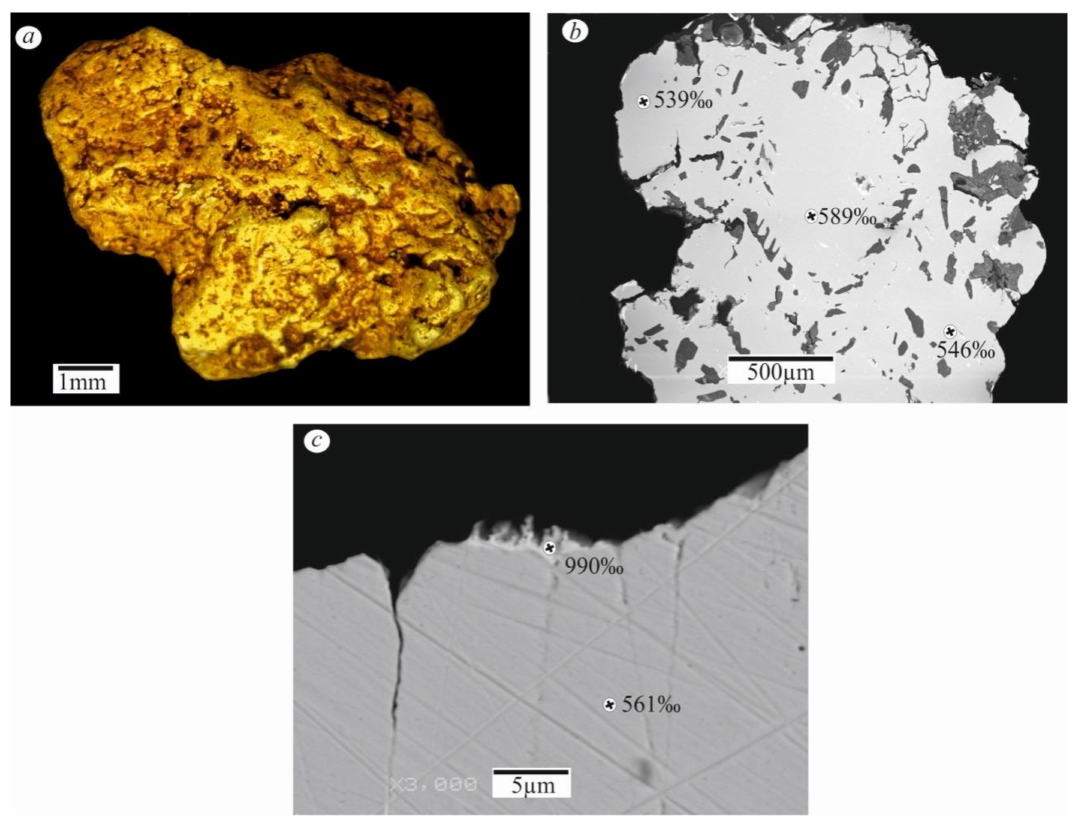
Figure 6. Characteristics of an unrounded mininugget of gold: ( a ) general view; ( b ) variations in fineness; ( c ) a thin and discontinuous high-fineness shell in an initial stage of generation at the periphery of the nugget. Photographed by a Color Digital Camera Levenhuk C800 NG